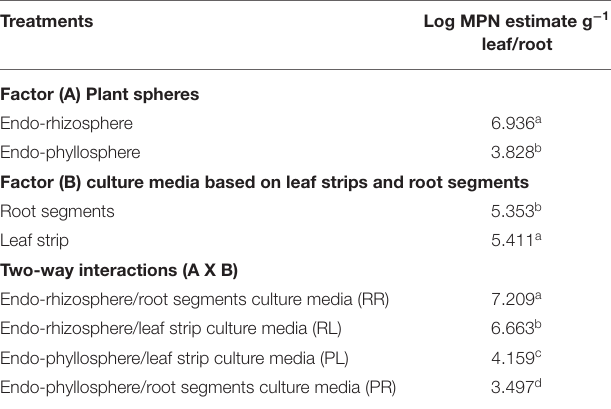
TABLE 2 | MPN estimates of endo-rhizosphere and endo-phyllosphere bacteria of sunflower plants as developed on leaf strips/root segments-based semi-solid culture media, under ambient oxygen conditions: two-way ANOVA analysis.